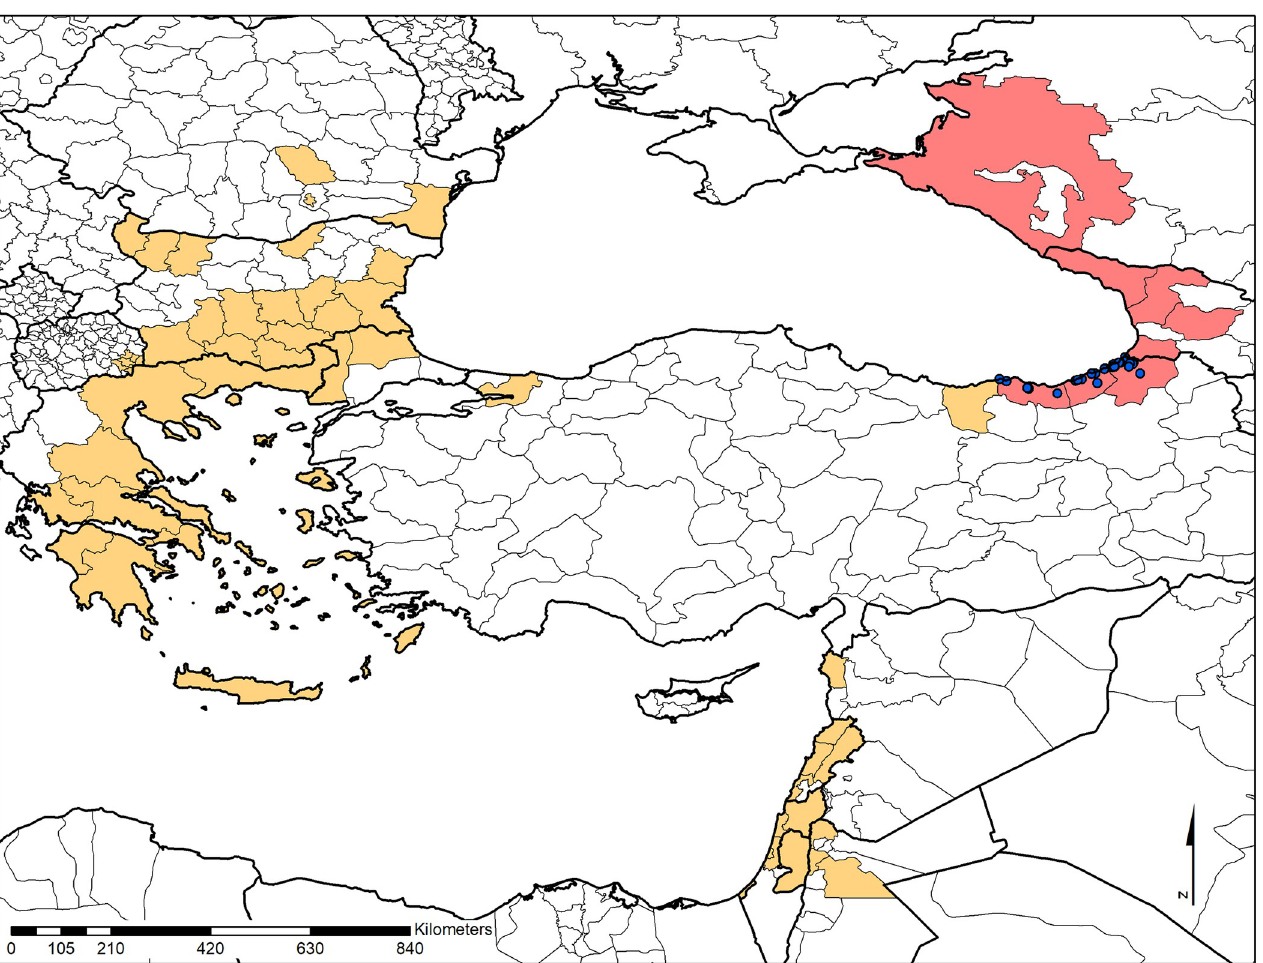
Fig 1. Map of the locations used for mosquito collection in the study. (Red: countries/territories with Ae . aegypti and Ae . albopictus ; Orange: countries/ territories with Ae . albopictus ). Blue dots represent sampling locations. The baseline map has been prepared using Natural Earth raster + vector map data in